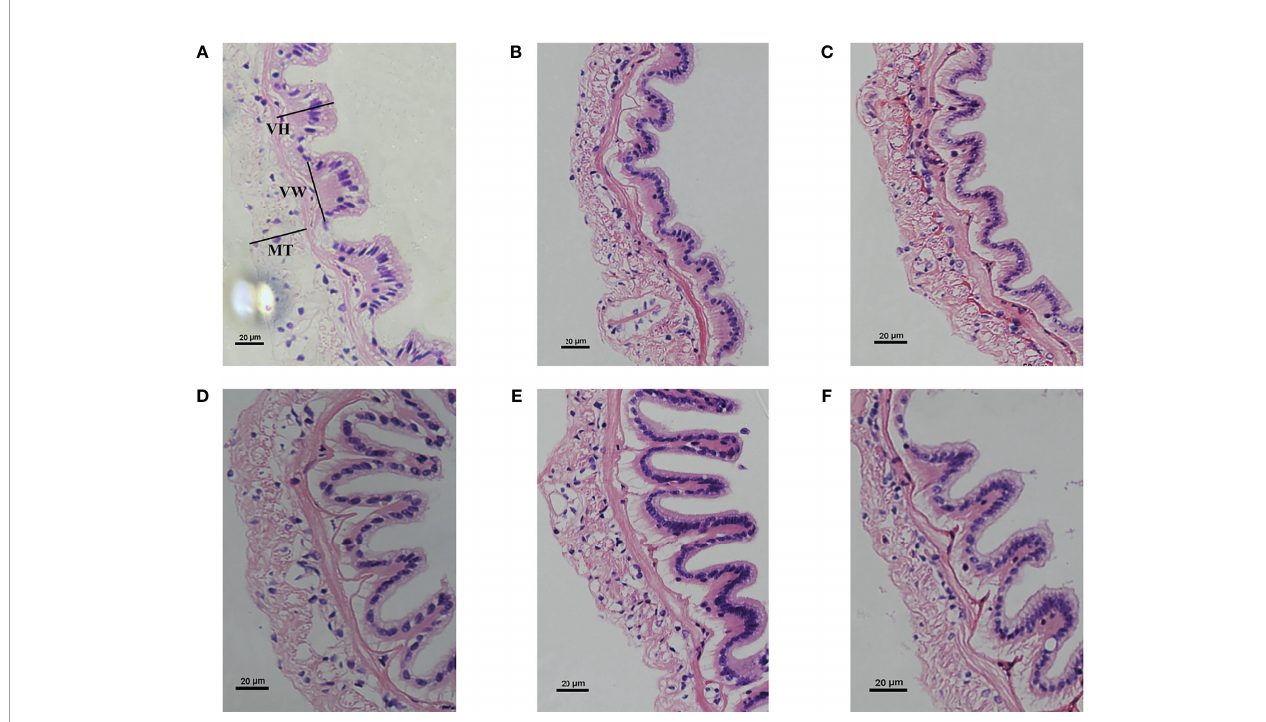
FIGURE 2 | Intestinal histology of Litopenaeus vannamei fed different levels of zymosan-A. (A – F) Groups Z0 (control), Z1, Z5, Z25, Z125, and Z625, respectively. VH , villus height; VW , villus width; MT , muscle